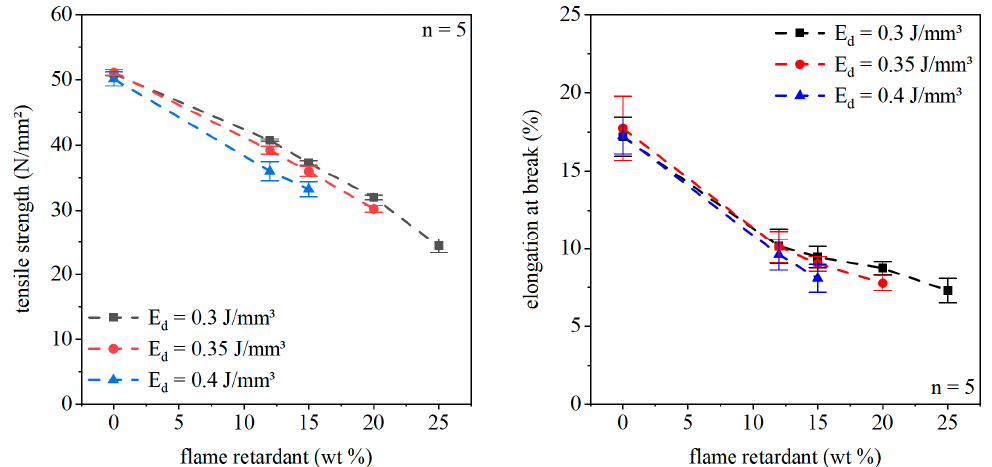
Figure 14. Tensile strength and elongation at break of the laser-sintered specimen for different flame retardant concentrations and energy densities.